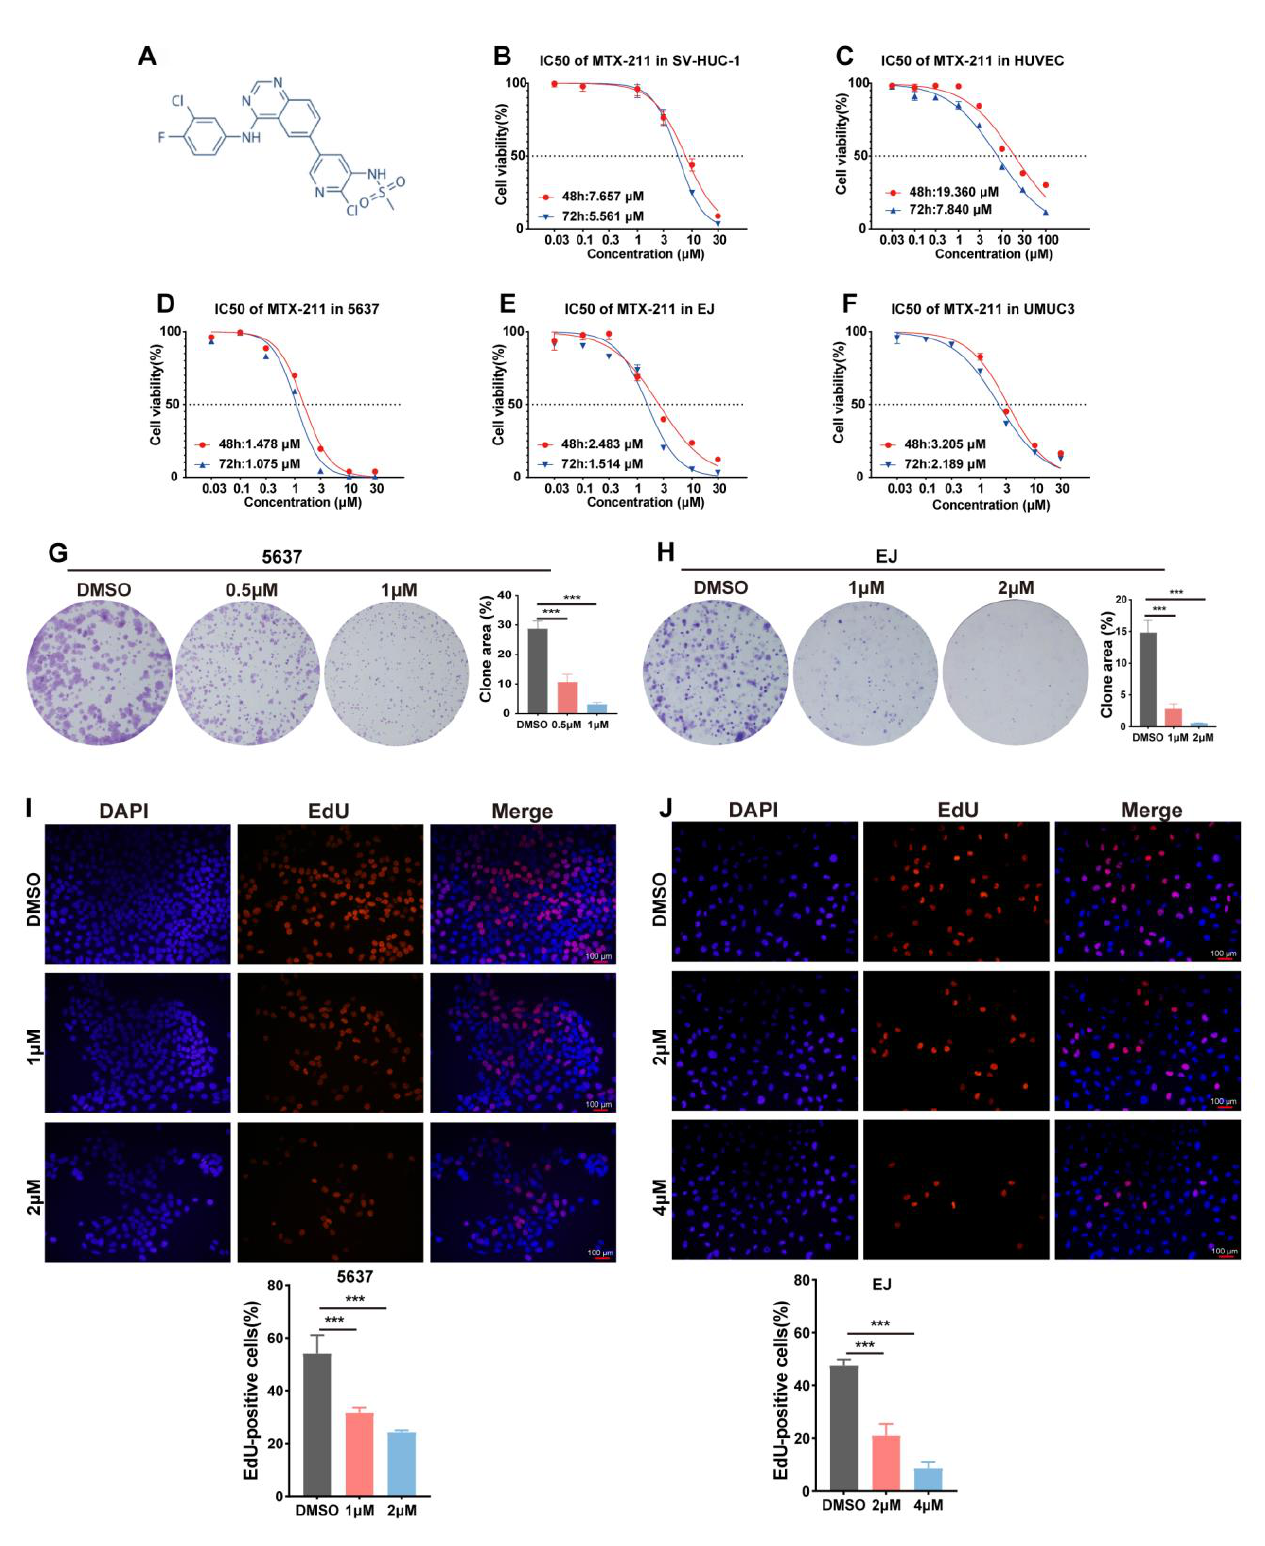
Figure 1. MTX-211 inhibits bladder cancer cell proliferation. ( A ) The structure of MTX-211. ( B – F ) The effects of treatment with different concentrations of MTX-211 for 48 and 72 h on the viability of bladder cancer cells. ( G , H ) The impact of MTX-211 on the colony formation ability of bladder cancer cells. ( I , J ) The effect of MTX-211 treatment for 48 h on cell proliferation was examined using the 5-ethynyl-2 (cid:48) -deoxyuridine (EdU) assay. *** p < 0.001. Scale bar: 100 µ